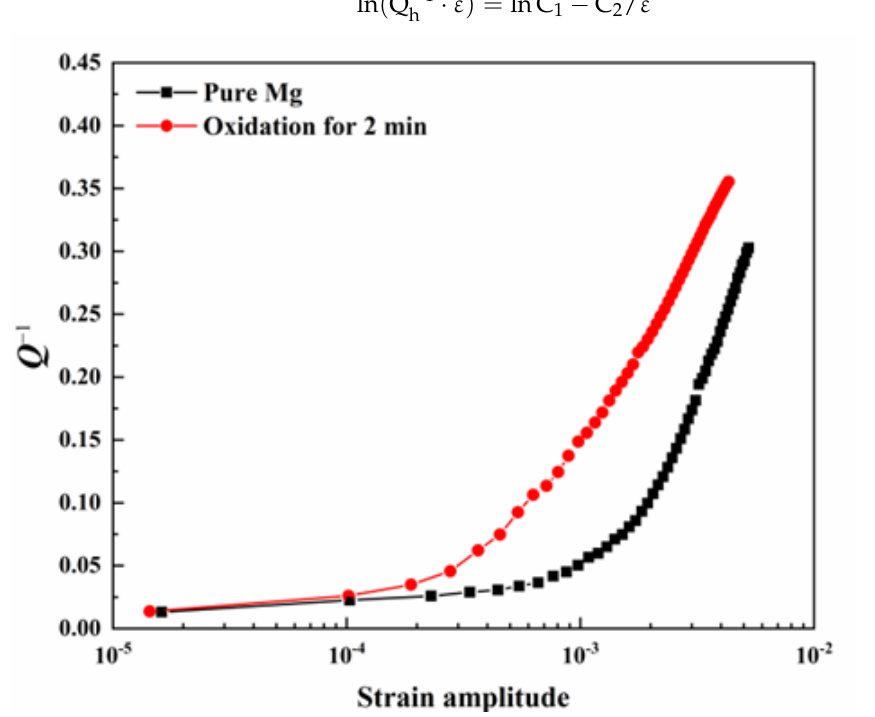
Figure 4. Strain amplitude-damping curve of MgO/Mg composites. Therefore, the G–L curves of pure magnesium and composite materials can be plotted. The curve of the pure magnesium and composite in the ε cr1 < ε < ε cr2 interval can be approximated as a straight line, as shown in Figure 5b, which is in good agreement with the G–L dislocation damping theory. However, as shown in Figure 5a. the G–L plots deviate from this straight line at high stain amplitude, which indicates that there are other damping mechanisms in the composite. This leads to a higher damping performance of the composite material than the matrix